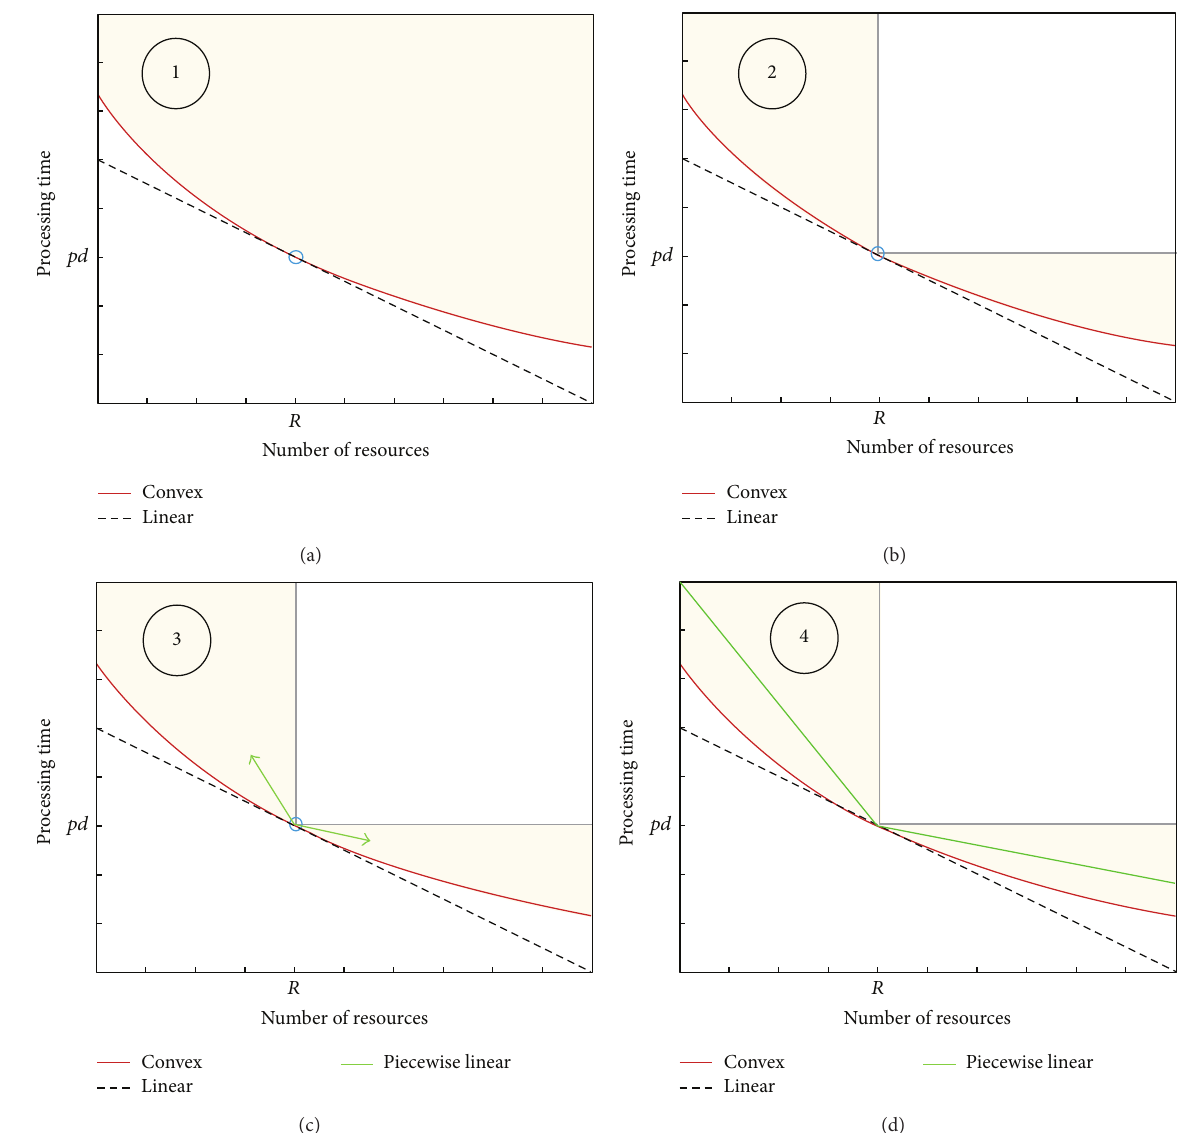
Figure 2: Relation between processing times and number of employees (shaded